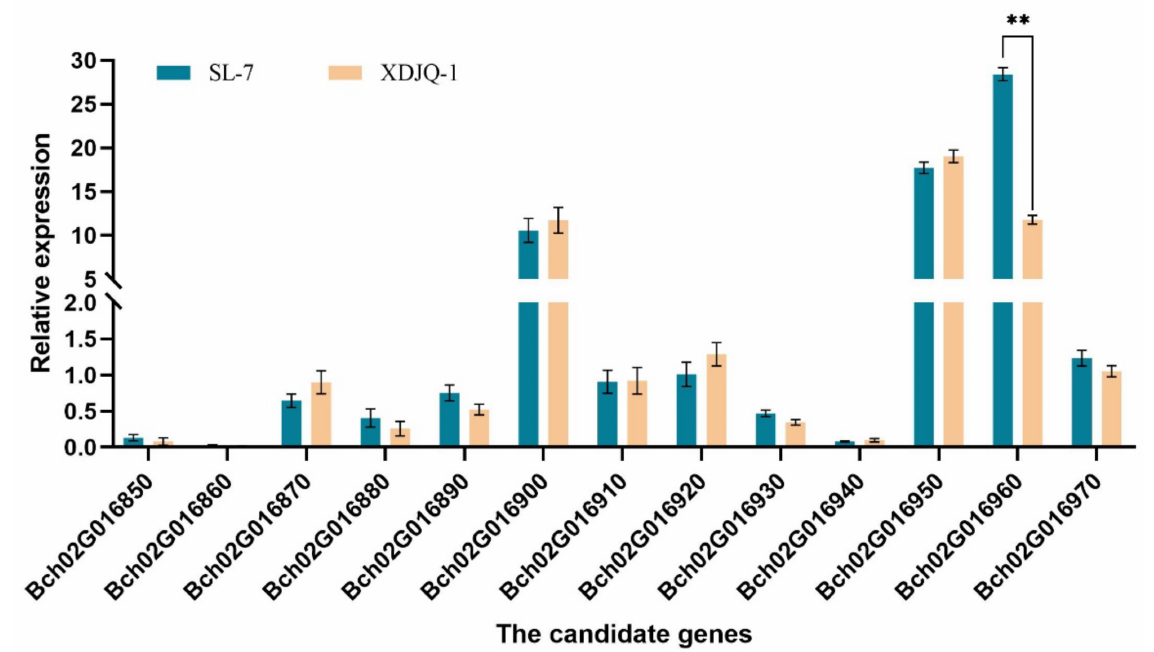
Figure 4. Expression levels of 13 candidate genes in the pulp of SL-7 and XDJQ-1 at 20 DAP. ** p <